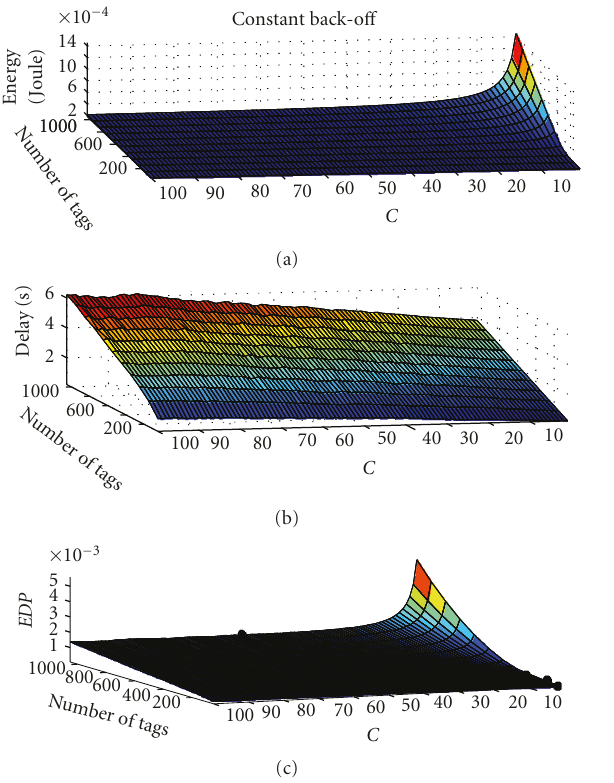
Figure 10: Linear back-o ff algorithm.